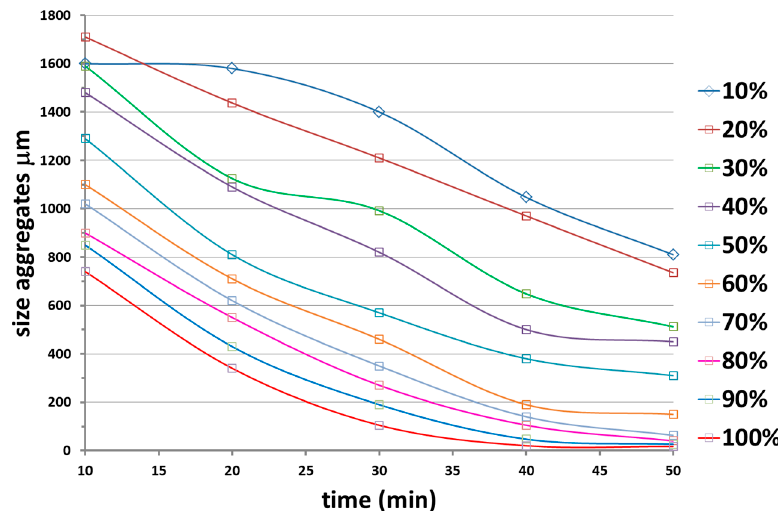
Figure 7. Effect of the ultrasound intensity at constant pulse of 75% on the size aggregation: evolution with the time of the size aggregates when ultrasound is applied at intensities ranging from 10 to 100%.